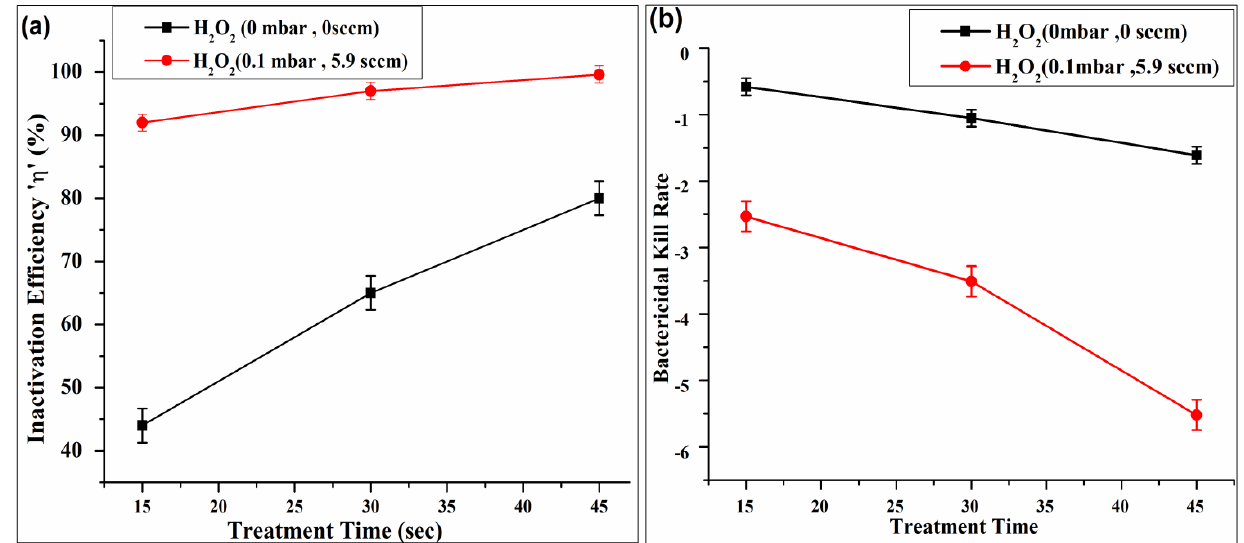
Figure 6. ( a , b ) Dependence of V. cholera inactivation efficiency and kill rate on plasma treatment time with and without H 2 O 2 vapors.